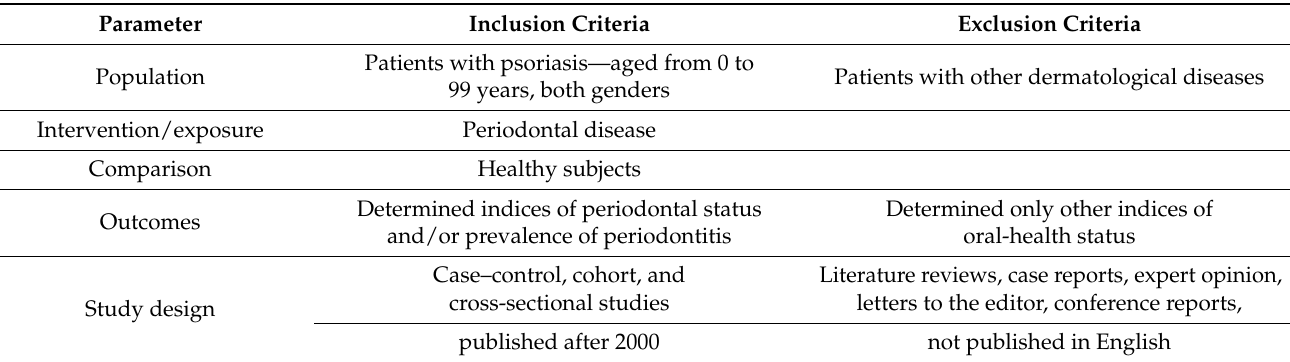
Table 1. Inclusion and exclusion criteria according to